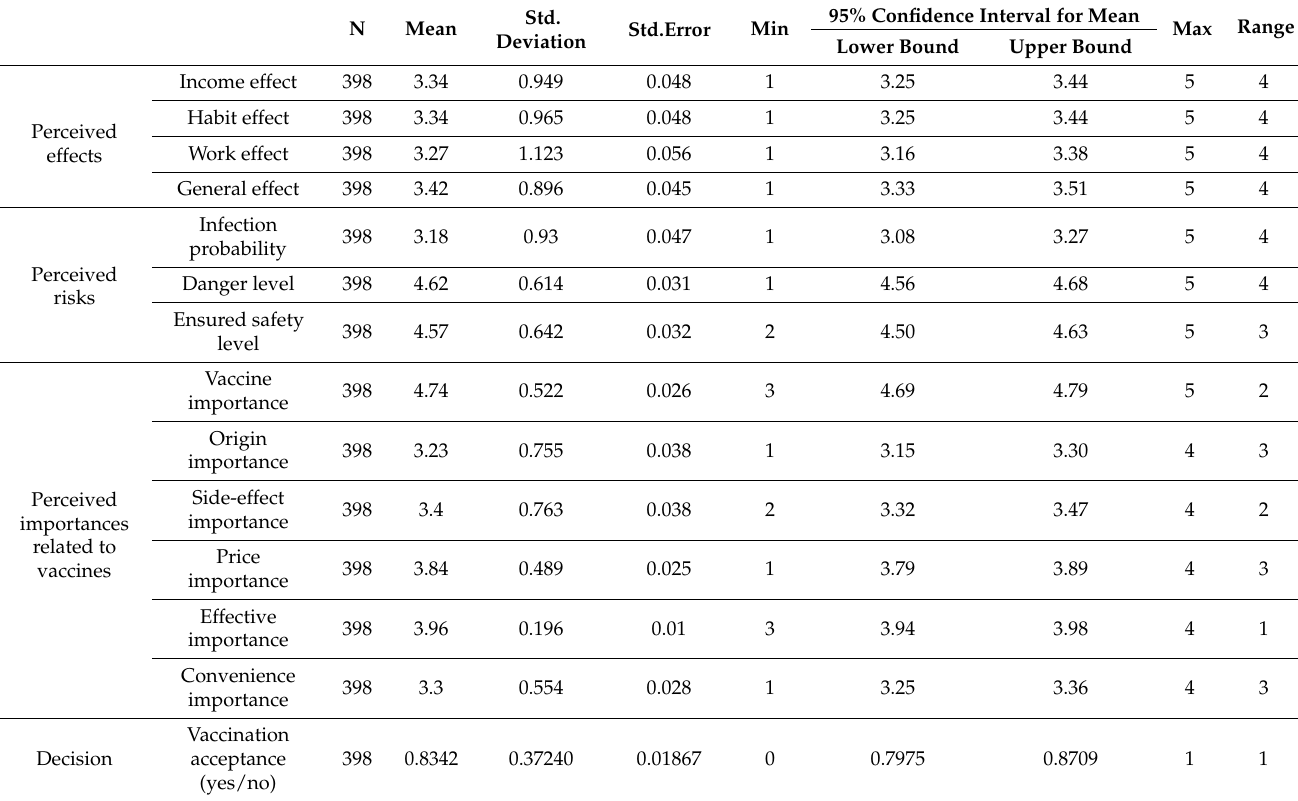
Table 3. Students’ perceptions of COVID-19 impacts and vaccines’ importance and